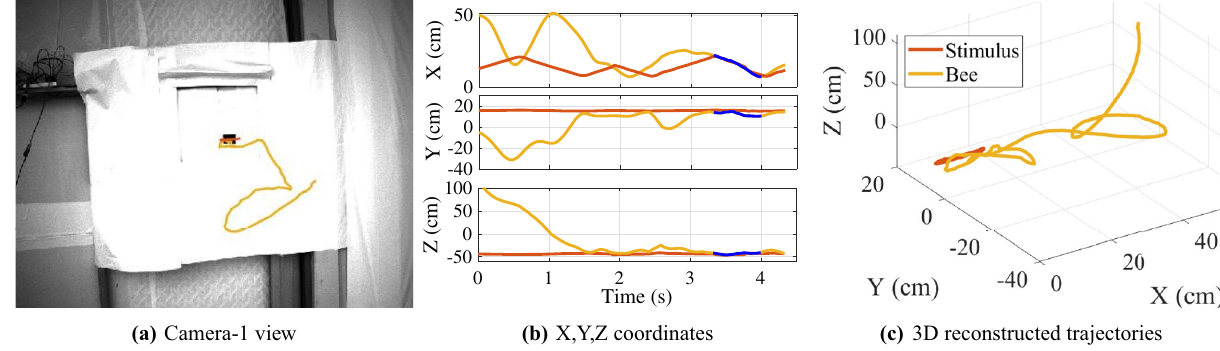
Figure 2. ( a ) A solitary insect’s trajectory (length 4 s) entering the moving entrance is captured by camera-1; ( b , c ): reconstructed position coordinates and 3D trajectory for both input stimulus and insect (blue color indicates Kalman